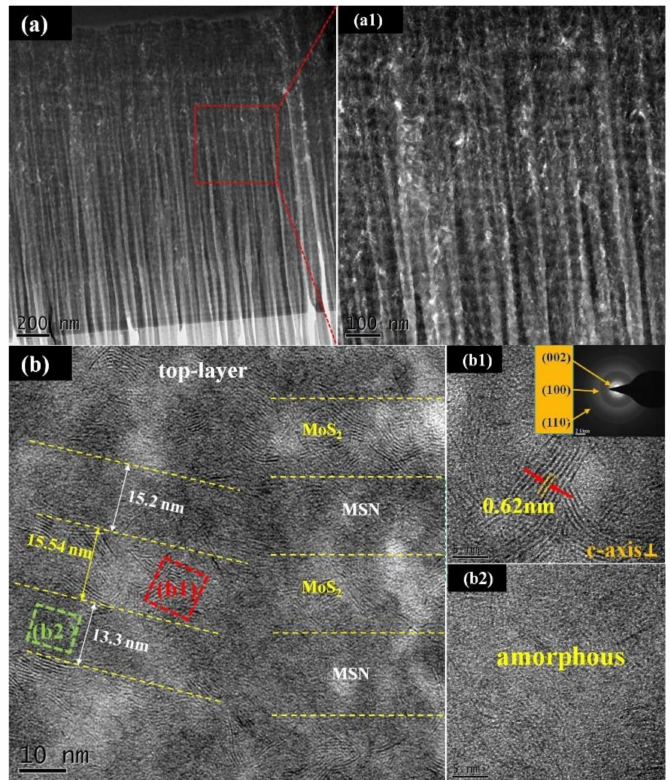
Figure 2. The cross-sectional HRTEM images of MoSN/MoS 2 multilayer film N6. ( a ) An overview of the FIB-prepared slice for HRTEM experiments, and ( a1 ) the magnified image of the selected region in ( a ); ( b ) the high-resolution image of the multilayer structure with closer observations of ( b1 ) MoS 2 and ( b2 ) MoSN